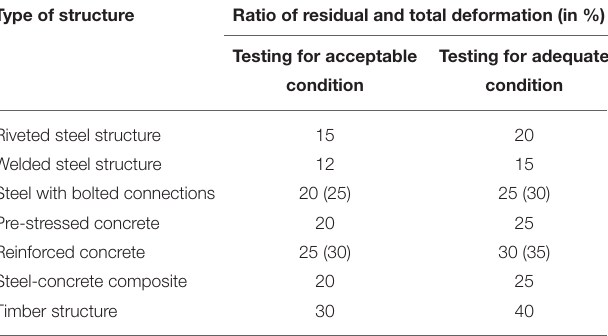
TABLE 4 | Limitations to deviation between measured and calculated deformations (Hungarian Chamber of Engineers, 2013). Type of